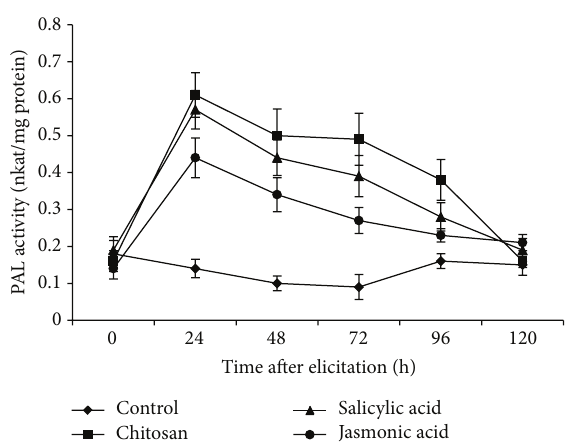
Figure 6: Cinnamyl alcohol dehydrogenase (CAD) activity (nkat/ mg protein) on a time course after elicitation of the roots of tomato with different elicitors. Values are mean ± SD of triplicate